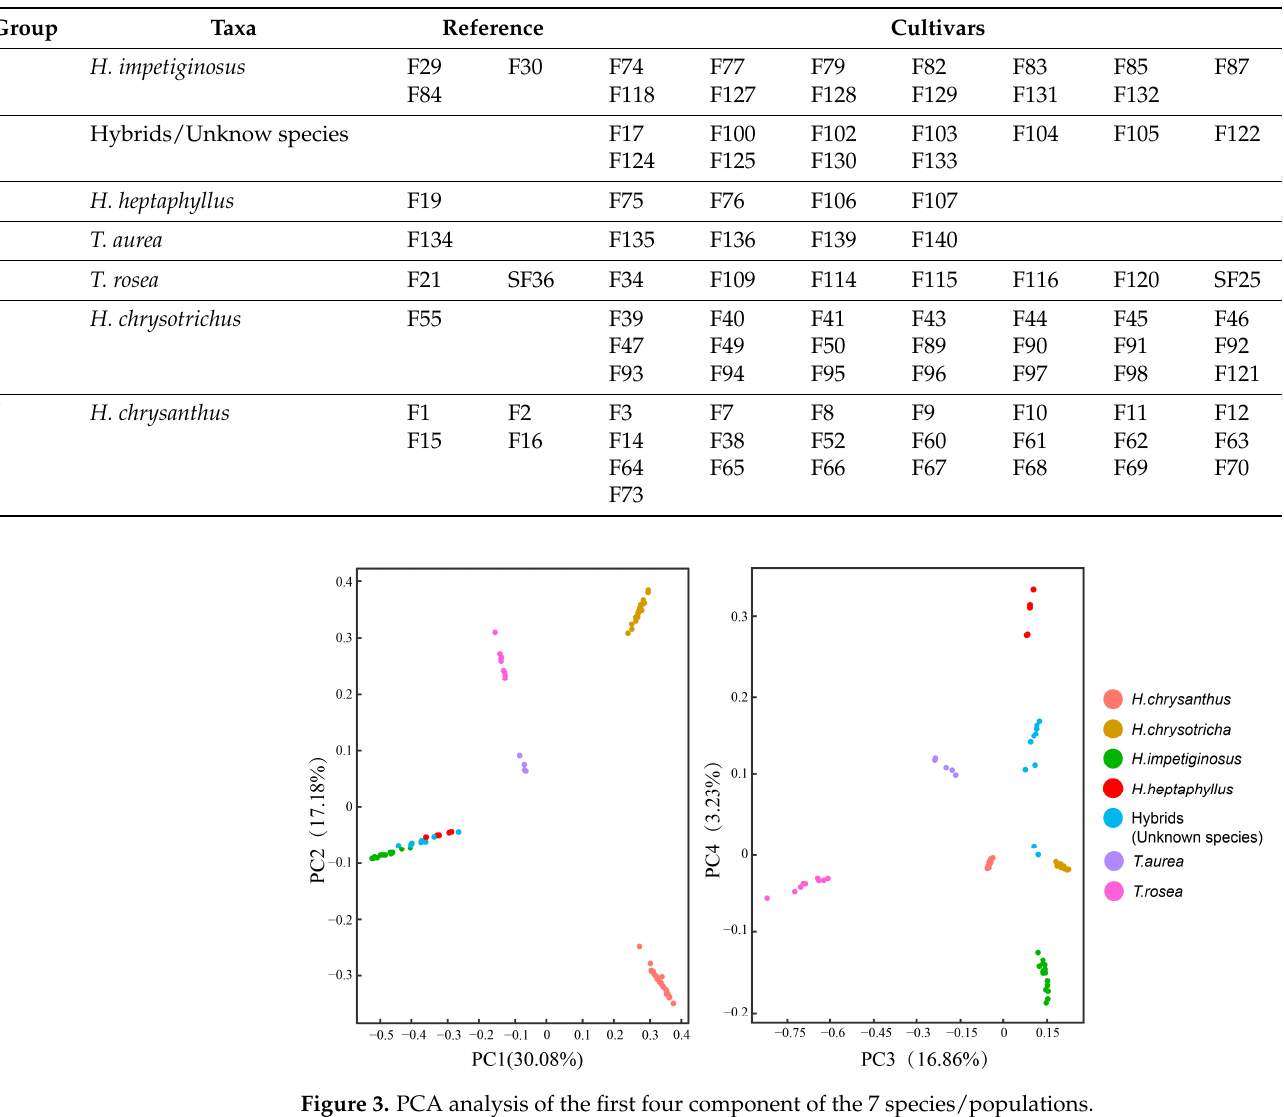
Table 2. The result of species identification of 82 cultivars.